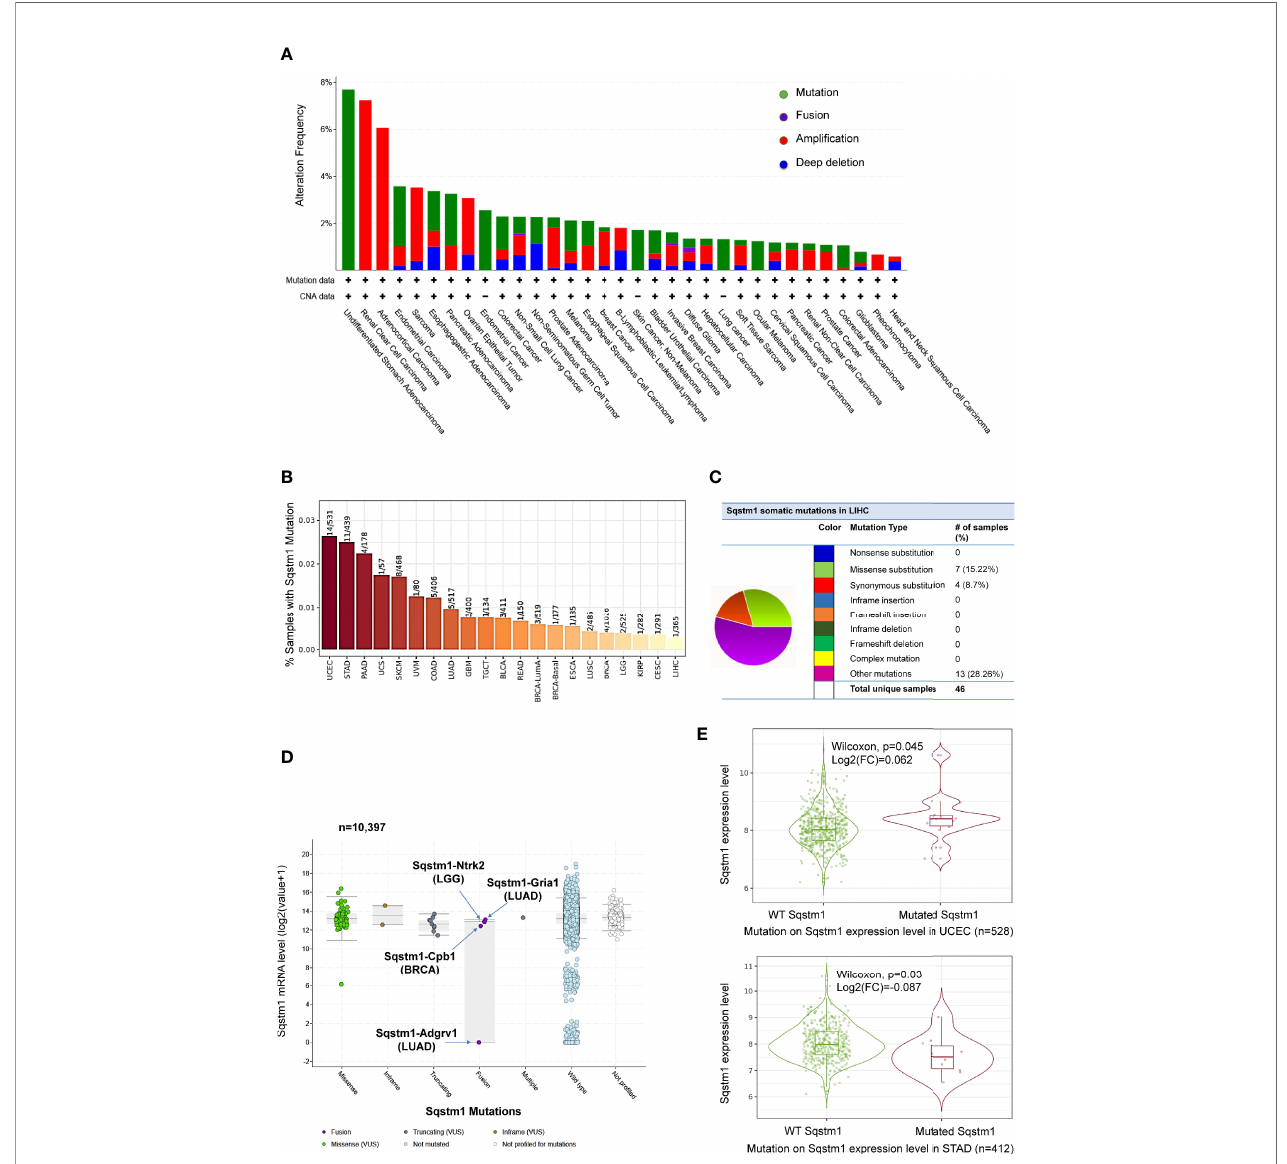
FIGURE 4 | Pro fi le of Sqstm1 gene mutation in cancers. (A, B) Frequencies of Sqstm1 gene mutation in various cancers. (C) Frequencies of Sqstm1 somatic mutations in LIHC. (D) Sqstm1 gene fusion and its effect on Sqstm1 expression in various cancers. (E) Representative results from UCEC and STAT showing the association of Sqstm1 mutation with its expression level. (A) is the results from cBioportal, (B) from TIMER2, (C) from COSMIC, (D) from cBioportal, and (E) from TIMER2. FC, Fold change (the differential expression levels between samples with WT and mutated Sqstm1